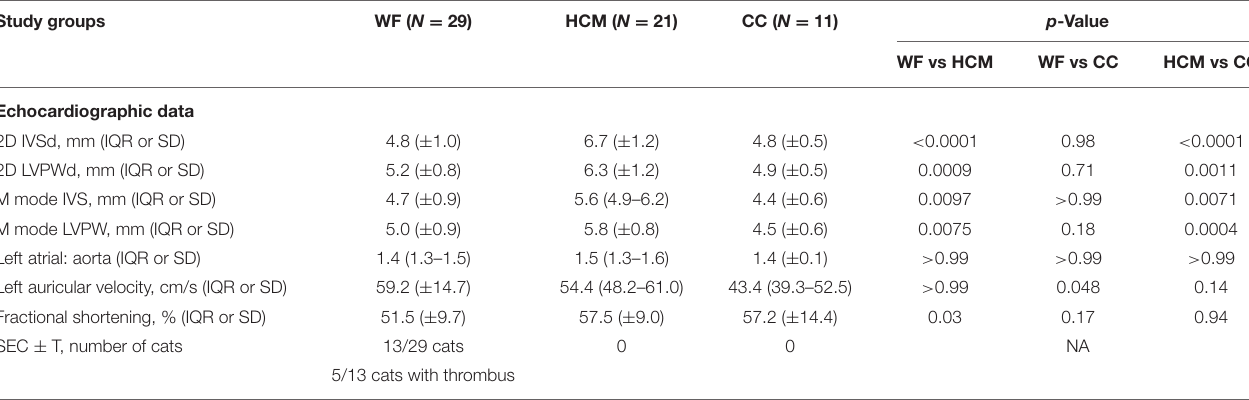
TABLE 3 | Patient characteristics of each study